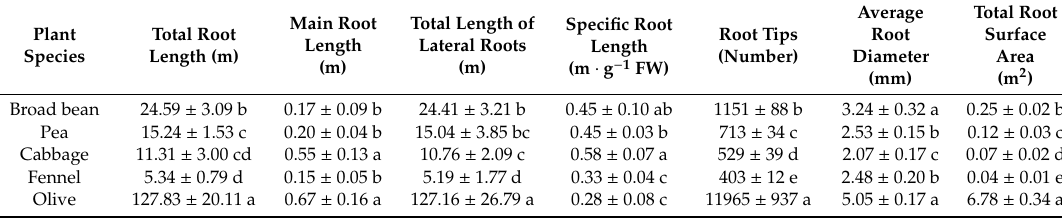
Table 1. Root morphological parameters measured by SmartRoot software in root portions of di ff erent plant species. Each value ( ± SD) represents the mean of five replicates (plants; n = 5) for each species. Five root portions were considered for each plant. The values followed by di ff erent letters (a–e) are statistically di ff erent ( p ≤ 0.01) within columns.